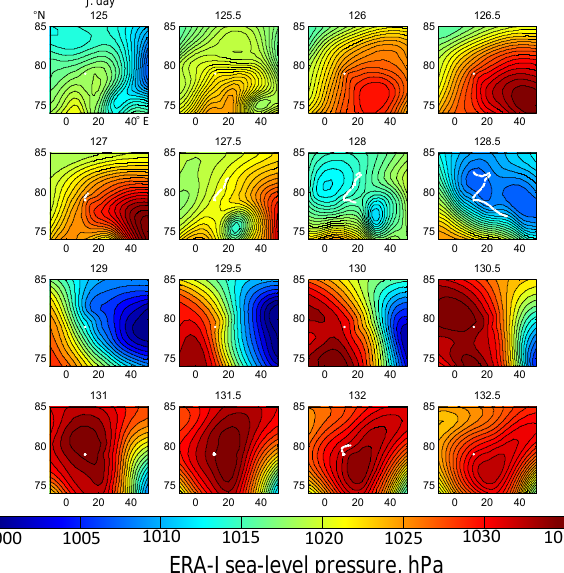
Figure 4. Meteorology parameter time series (resolution in min- utes) from the Ny-Ålesund AWIPEV station compared to ERA-I (6-hourly) and ASR (3-hourly) outputs for pressure, temperature, relative humidity, U and V winds. Wind roses compare modelled and observed wind